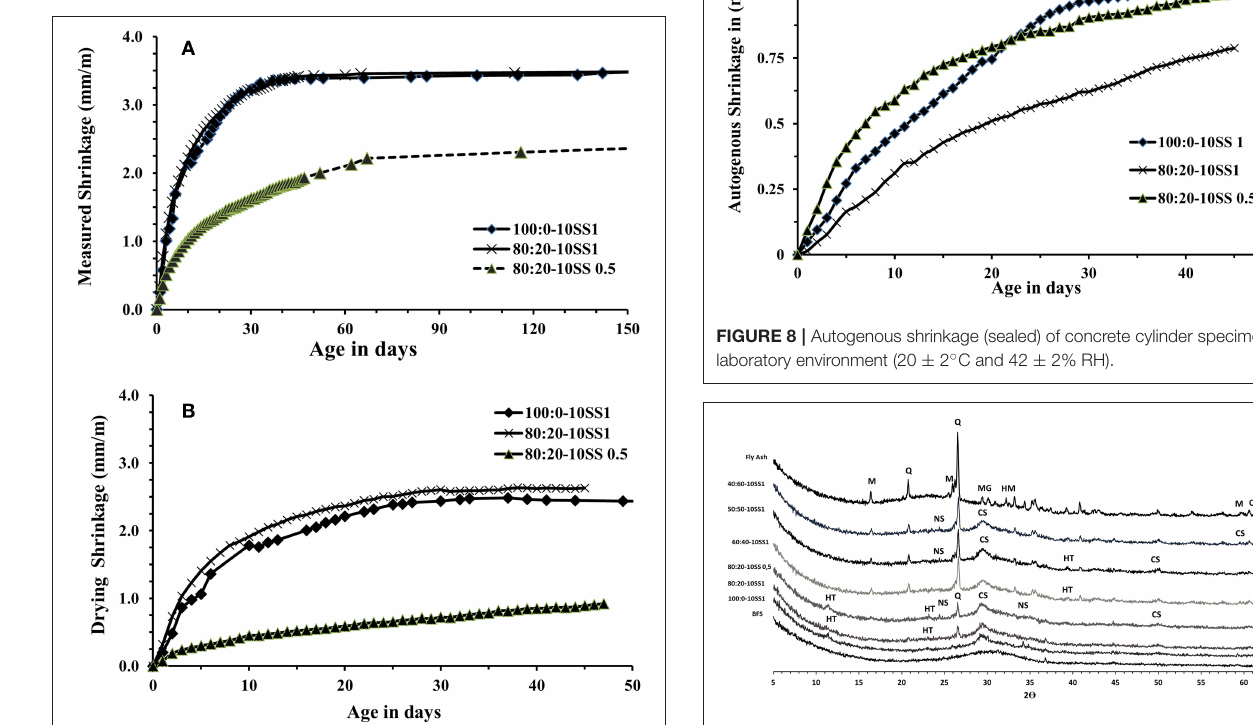
Frontiers in Materials |